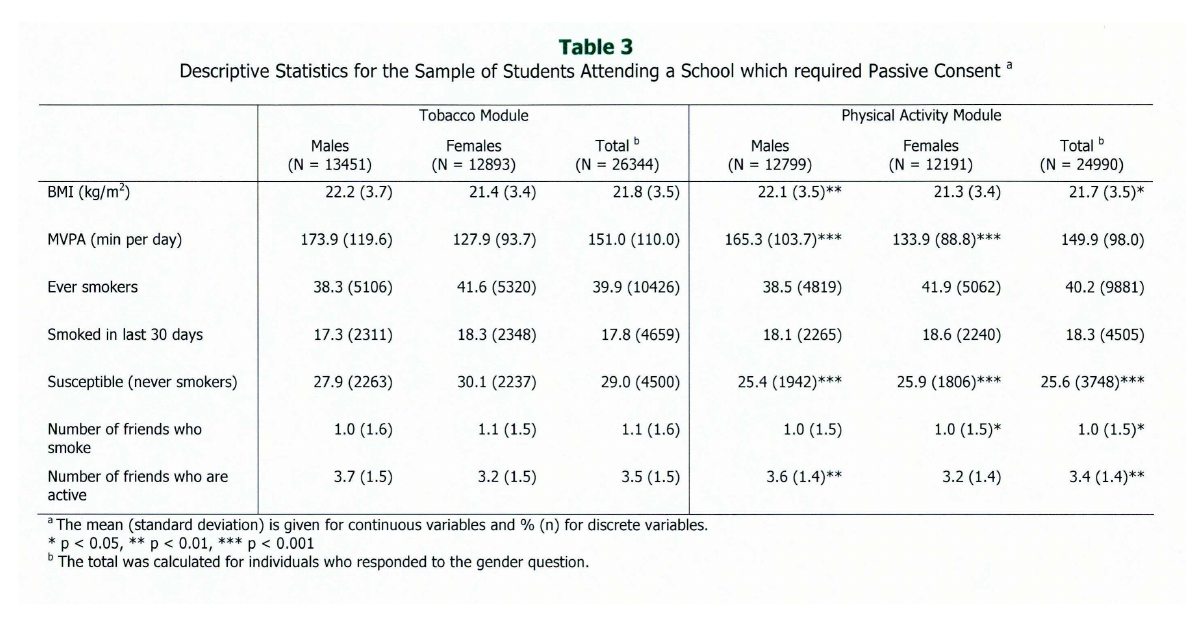
Table 3 highlights differences in the core behavioural measures between the TM and PA samples. Students who completed the TM were significantly different from students who completed the PA Module with respect to BMI, the susceptibility score, the number of friends who smoke and the number of active friends. Among the males who completed core sections within each module, students were found to be significantly different with respect to most demographic variables, with the exception of the number of friends who smoke, whether the student had ever smoked and whether the student smoked in the last 30 days. Among the female responses to core questions, students were significantly different with respect to MVPA, the number of friends who smoke and the susceptibility score. The males who completed the TM reported a higher MVPA than the males who completed the PA Module. Conversely, the females who completed the TM reported a lower MVPA than the females who completed the PA Module. The sequence of questions in a questionnaire does matter since it is different between the two modules. The physical activity questions are at the end of the TM and similarly, the smoking questions are at the end of the PA